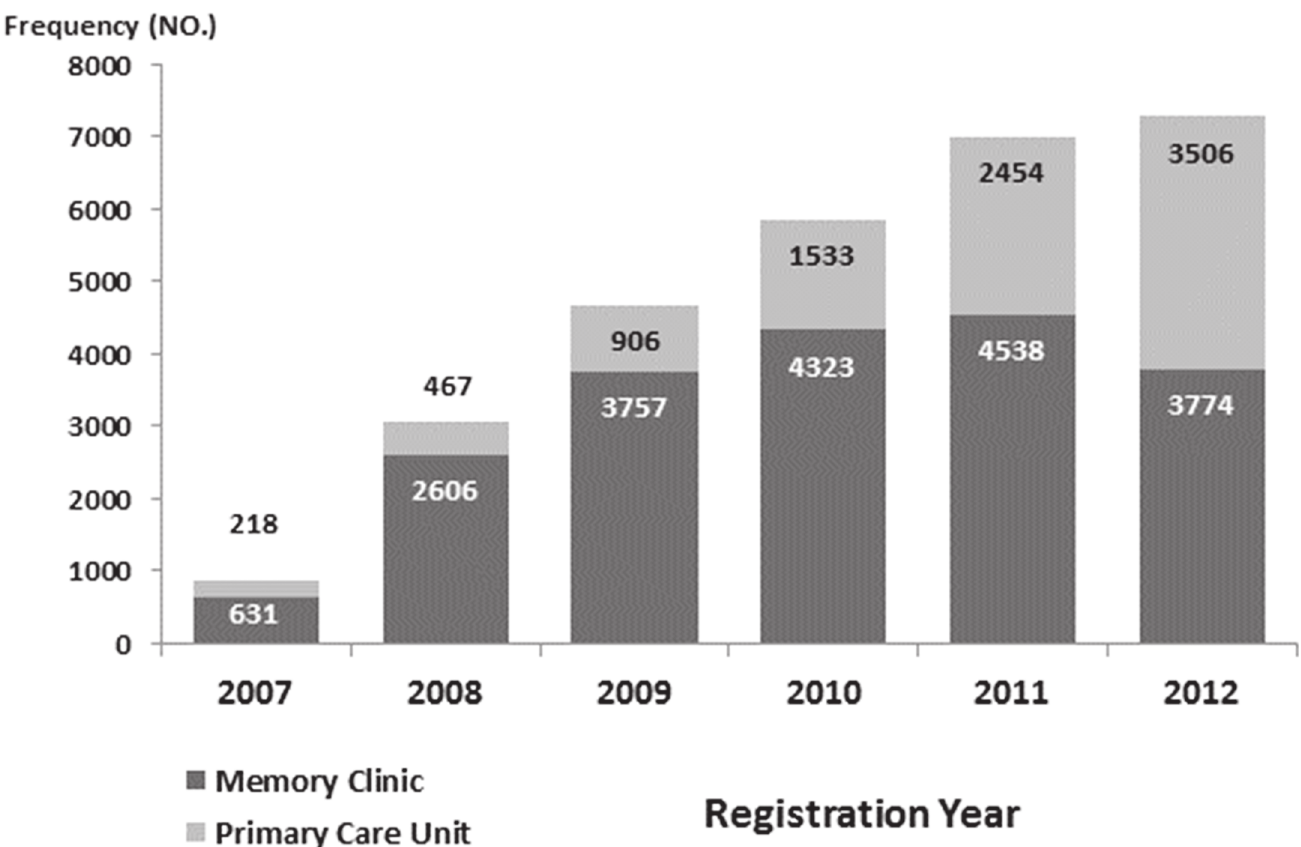
Fig 3. Frequency of dementia patients registered at specialist (memory clinic) and primary care units in SveDem during 2007 – 2012 (n =